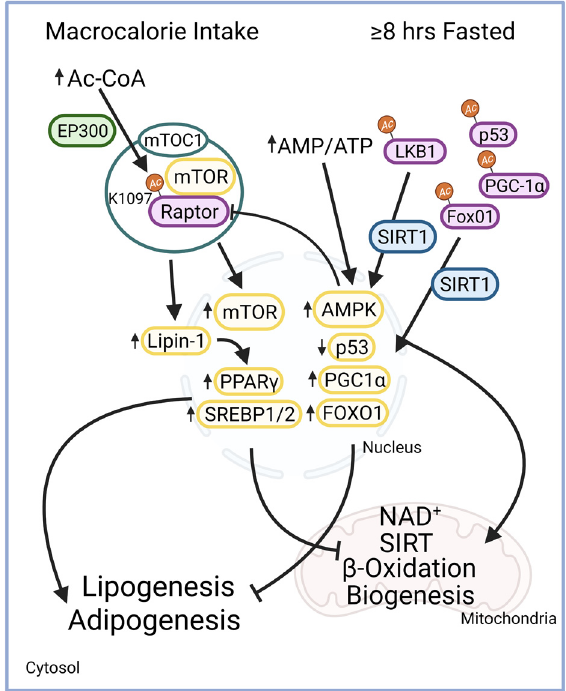
Figure 3. mTOR and AMPK respond to fasted and fed states. During a fed state, increased Ac-CoA is observed along with decreased NAD + resulting in reduced SIRT activity. mTORC1 is regulated through acetylation of Raptor by EP300, an acetyltransferase, subsequently inducing mTOR signal- ing [61] . This results in the phosphorylation of lipin-1 and the activation of lipogenic and adipogenic transcription factors SREBP1/2 and PPAR- 𝛾 [46] . A fasted state occurs in hepatocytes after 8-12 hours of restricted caloric intake resulting in the activation of AMPK by two mechanisms, increased AMP/ATP ratio and LKB1 phosphorylation [48] . SIRT1 activity is altered through AMPK-enhanced NAD + concentrations, thus enabling SIRT1 to deacetylate LKB1 and activating AMPK [54] . SIRT1 also regulates p53, PGC-1 𝛼 , and FoxO1 to promote mitochondrial biogenesis [49,55] .